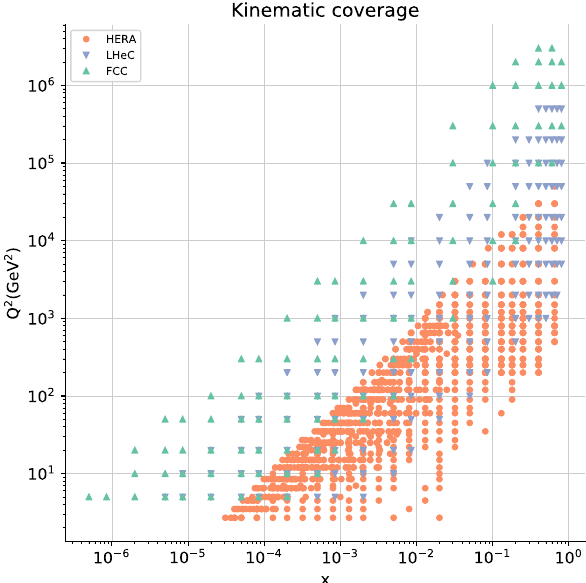
Fig. 34 Kinematiccoverageinthe ( x , Q 2 ) planeoftheFCC-ehandthe LHeC experiments, compared to the kinematic coverage of the HERA structure function data